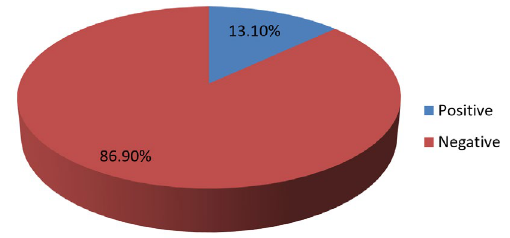
Fig. 1. Confirmed Cutaneous TB positive